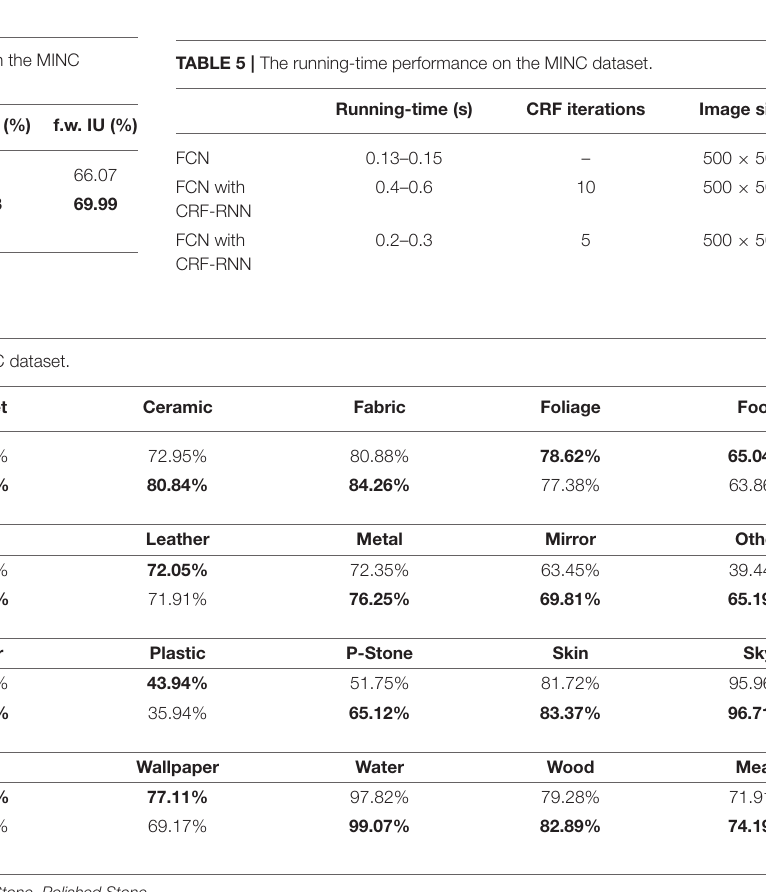
Frontiers in Robotics and AI |